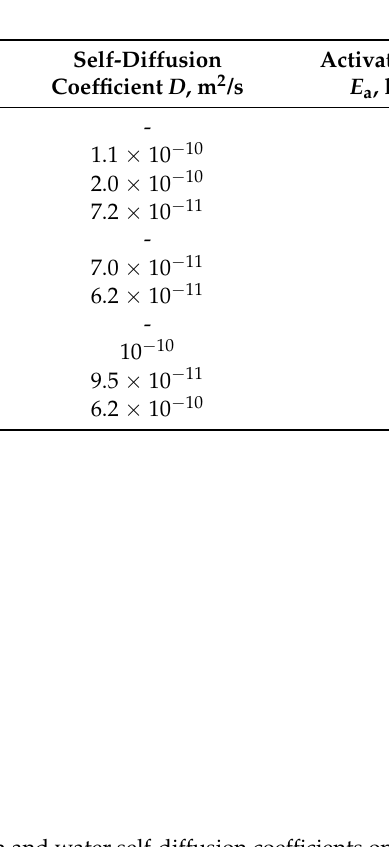
28 of 41 Table 12. Self-diffusion coefficients D at 293 K and self-diffusion activation energies E a of F − ions in the AV-17 resin and in the membranes ACLE-5P and ASV equilibrated with water or an aqueous solution of NH 4 F × HF. Ion-Exchange Material